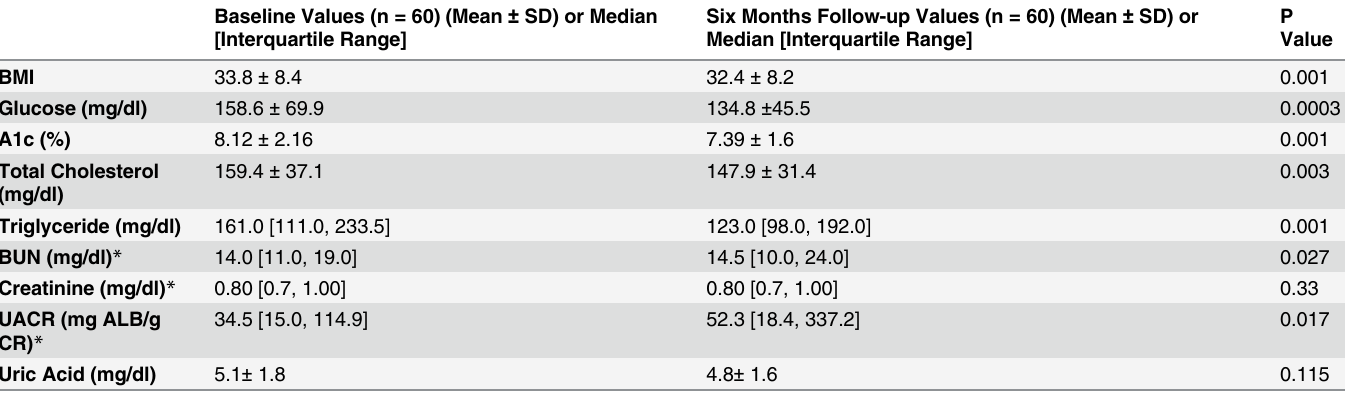
Table 1. Demographic and clinical characteristics of fasting study participants at baseline and at 6 month of